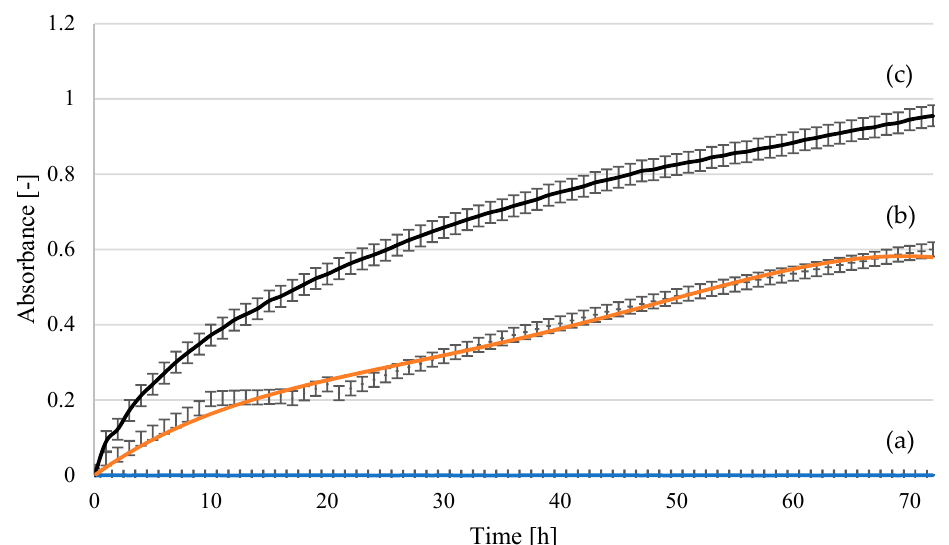
Figure 17. Yeast growth curves for the Saccharomyces cerevisiae Tokay LOCK0204 strain in fermentation media: ( a ) uninoculated medium—reference sample; ( b ) hydrolysate following treatment at 140 ◦ C, 2 h, 2% H 2 SO 4 ; ( c ) hydrolysate following treatment at 140 ◦ C, 2 h, 2% H 3 PO 4 . The curves show the mean values obtained in three independent measurements. Table 2. Yeast cell multiplication.